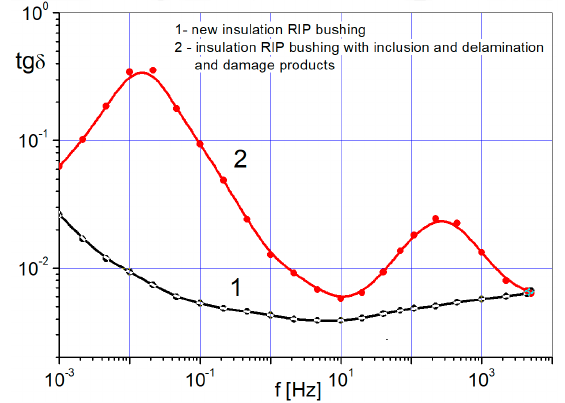
Figure 3. Typical relationships tg δ = f(f) for RIP bushings insulation under different conditions.